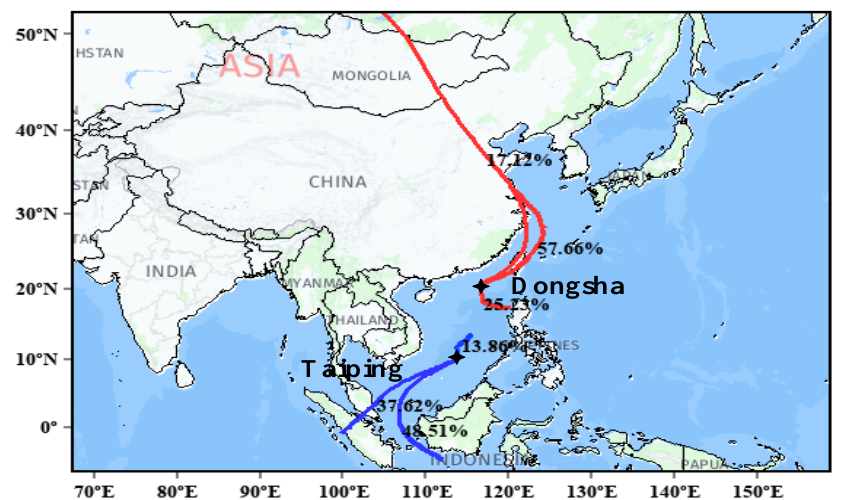
Figure 5. Five-day trajectories ending at Dongsha (15 March to 20 April every year) and Taiping (10 August to 30 September every year) at 500 m during high aerosol loading.